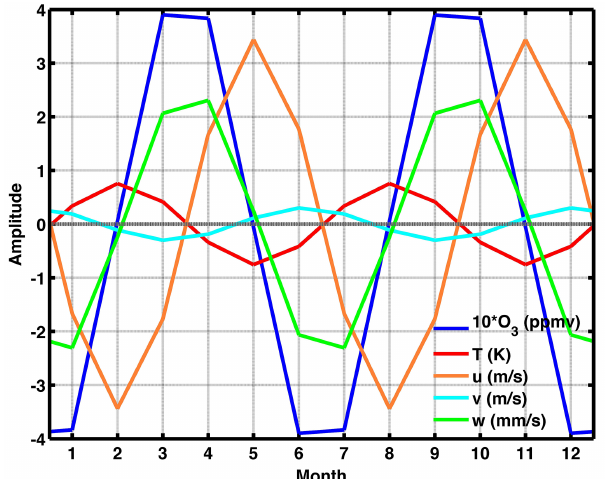
Figure 4. The profile of the amplitude of ozone-SAO in ppm (blue line) and its phase given as the month of the maximum (red line) are shown in the left and middle panel. The amplitude of the ozone- SAO depending on the months of the year is represented in % in the right panel.